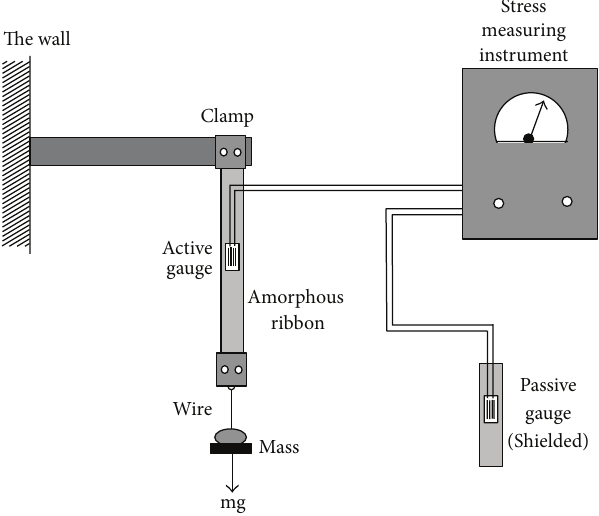
Figure 2: Block diagram of the calibration system of the bridge (the other two arms of the bridge are internal to the measuring instru-